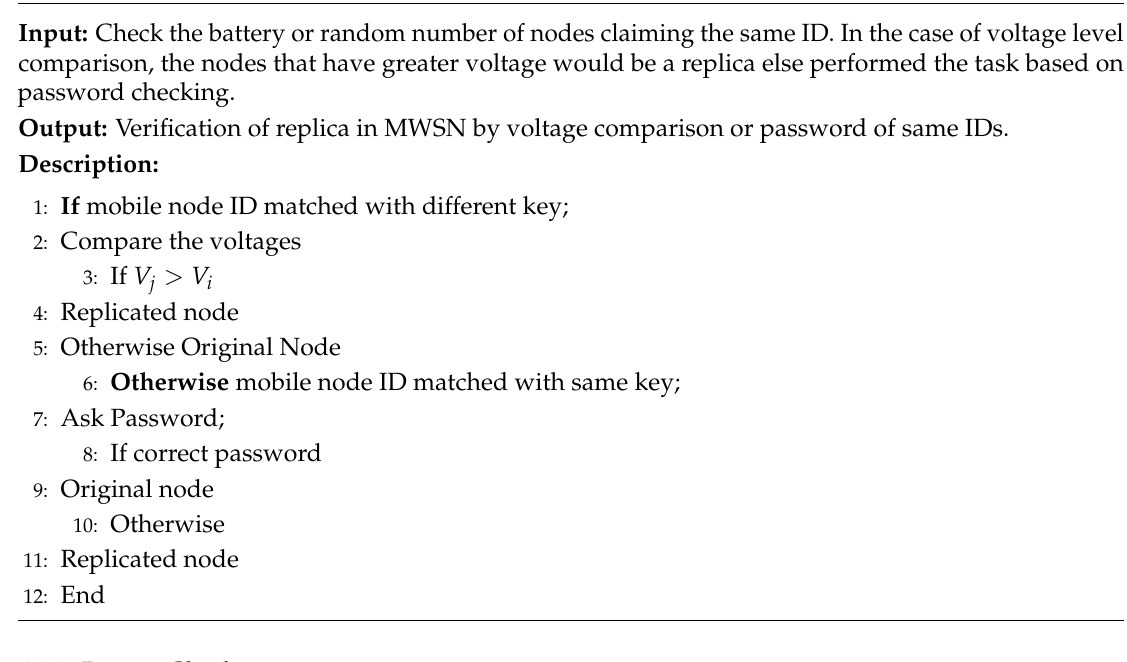
Algorithm 2 Battery Check and Random Number (Second Level